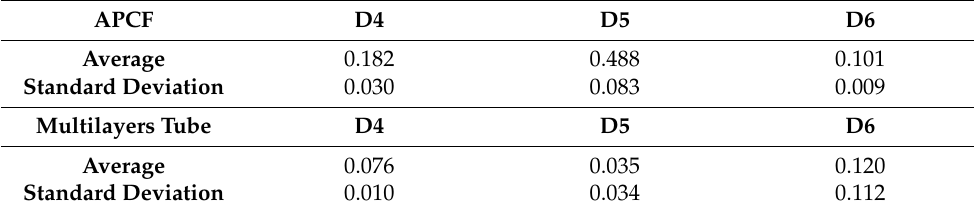
Table 5. Biogas sampling results: comparison between APCF and standard tube (ng mL − 1 ).